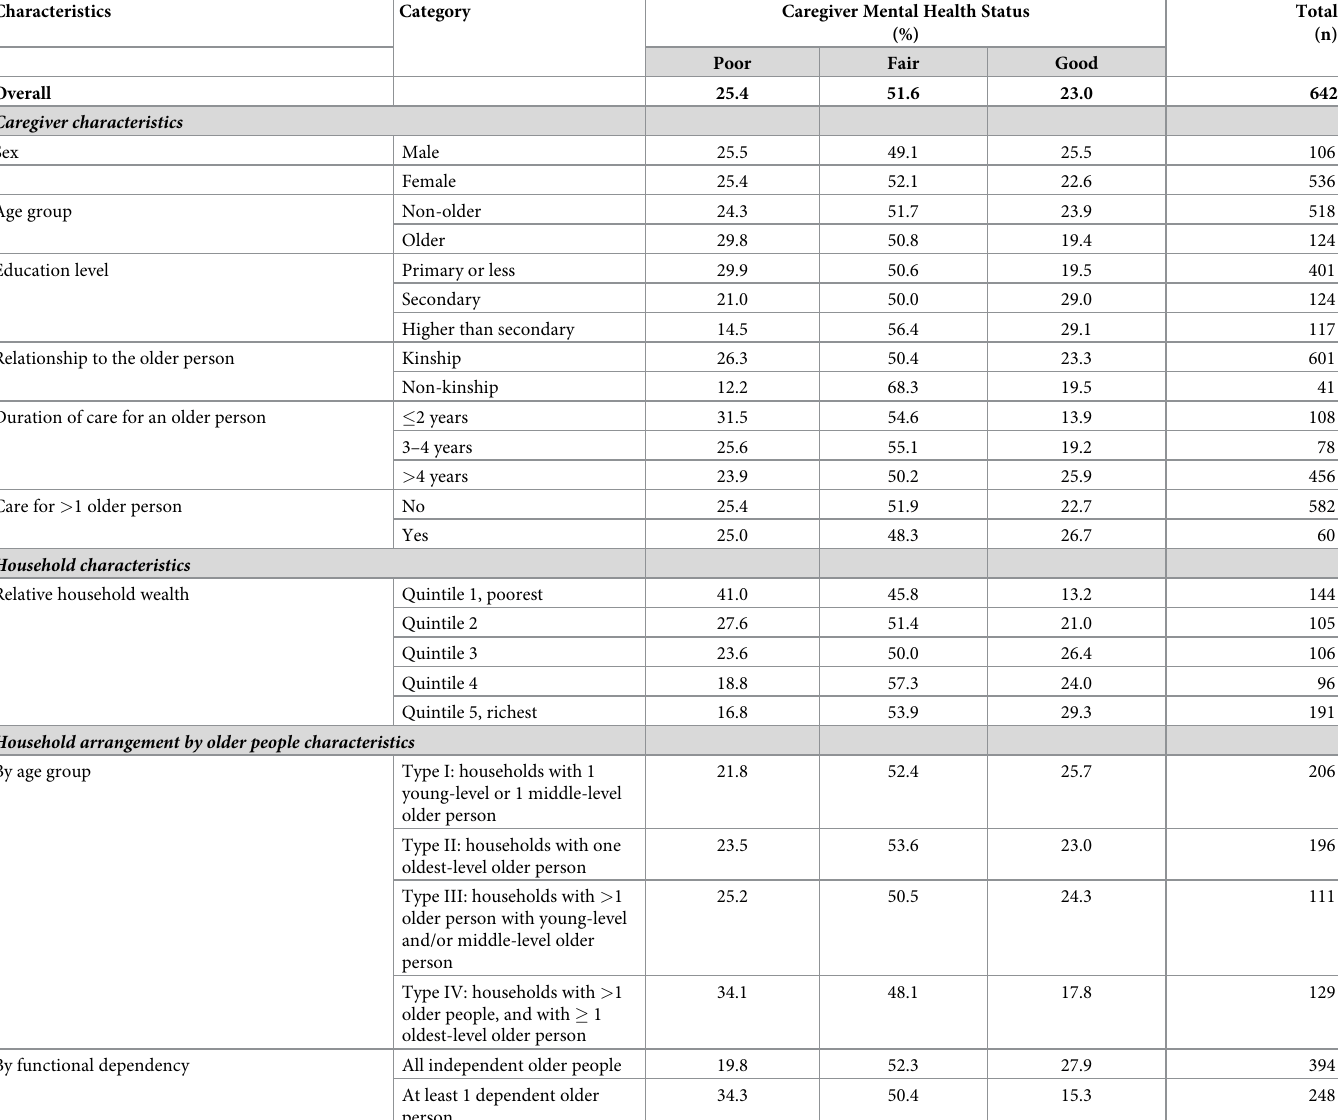
Table 2. Percentage distribution of mental health status of caregiver by caregiver characteristics, household characteristics and household arrangement,